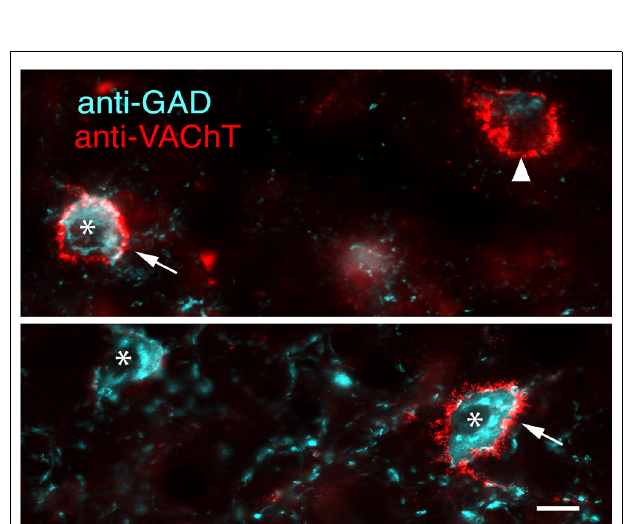
FIGURE 7 | Photomicrographs showing anti-VAChT co-staining with WFA-labeled PNs in the IC. Top row: PNs in the ICc are stained withWFA. Right column is an enlargement of boxed area in top left photograph. Middle row: the same areas as top row, viewed to reveal anti-VAChT staining. Bottom row: merged images; yellow color indicates regions of direct overlap of green and red signals. Solid arrowheads: PNs labeled with WFA only; Open arrowheads: PNs labeled withVAChT only. Arrows: PNs labeled with bothWFA andVAChT. Scale bars = 50 μ m. Case GP691.